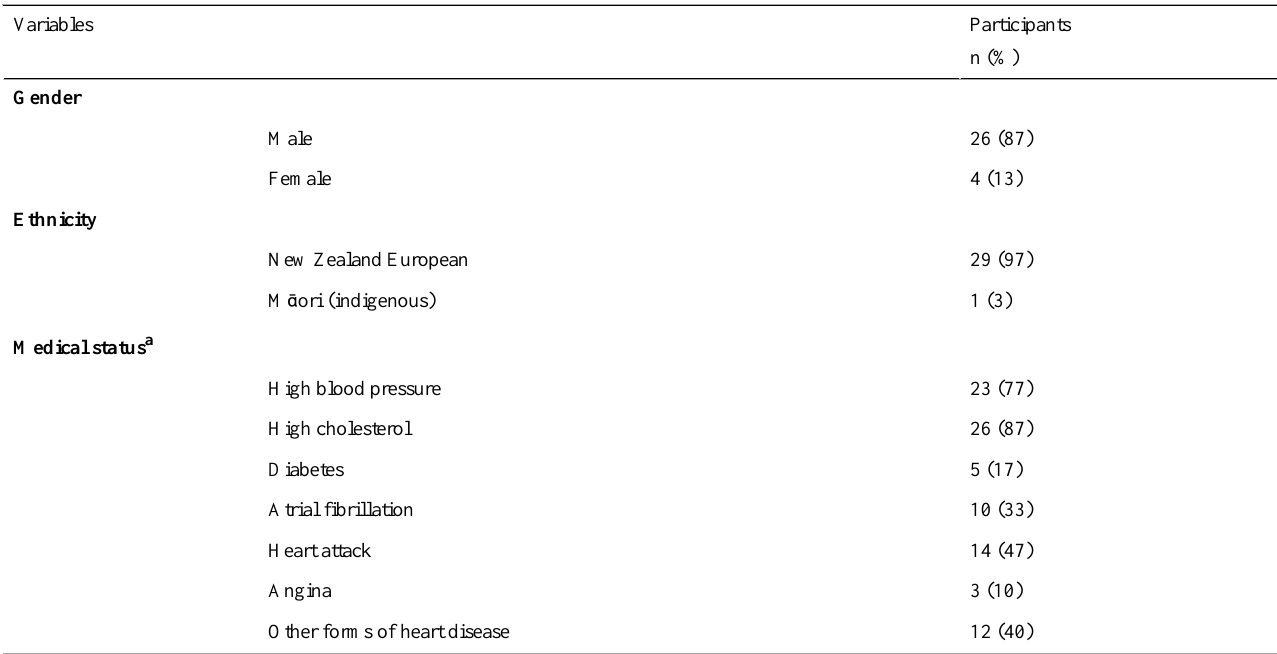
Table 2. Participant characteristics (N=30).